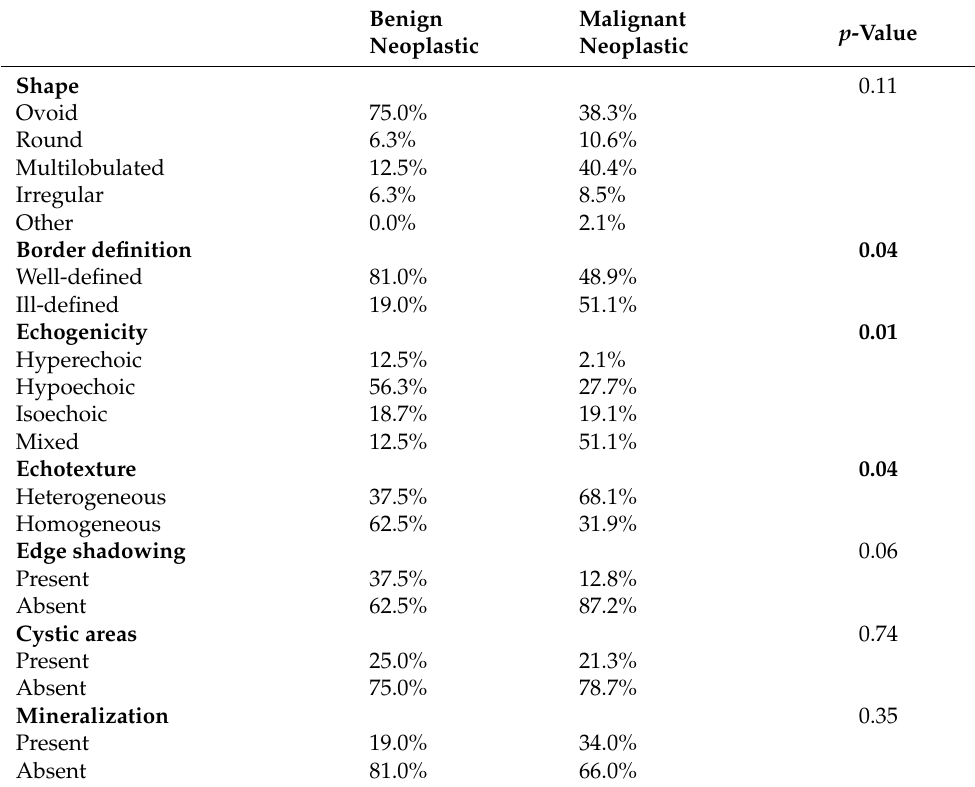
Table 2. An overview of ultrasonographic characteristics obtained by B-mode ultrasonography for benign and malignant neoplasms.